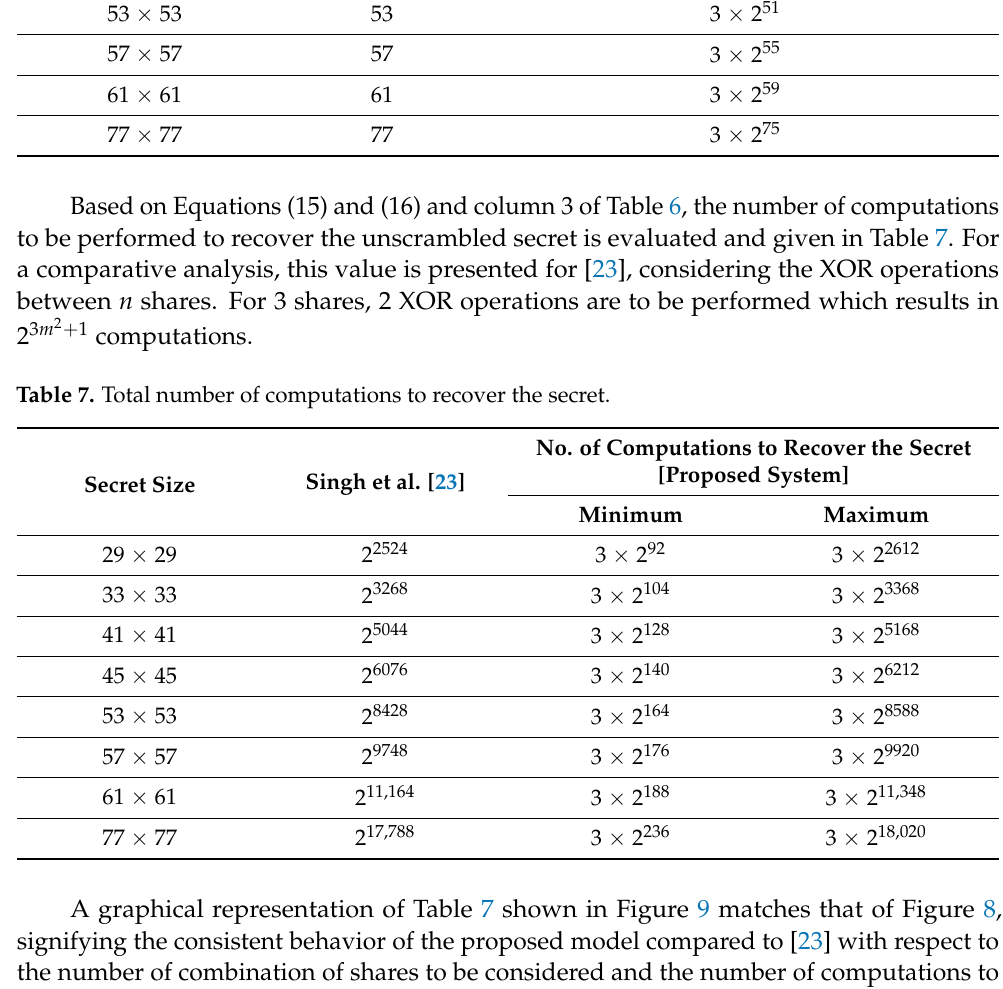
Table 6. Number of iterations of Arnold Transform to unscramble the secret. Size of Secret